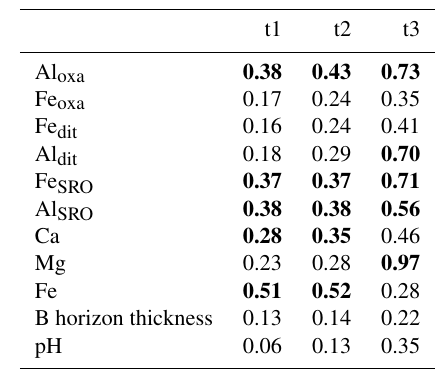
Table 3. Intragroup community indexes of soil physico- geochemical variables relative to orthogonal canonical components of vegetation variables. Values with the highest scores are indicated in